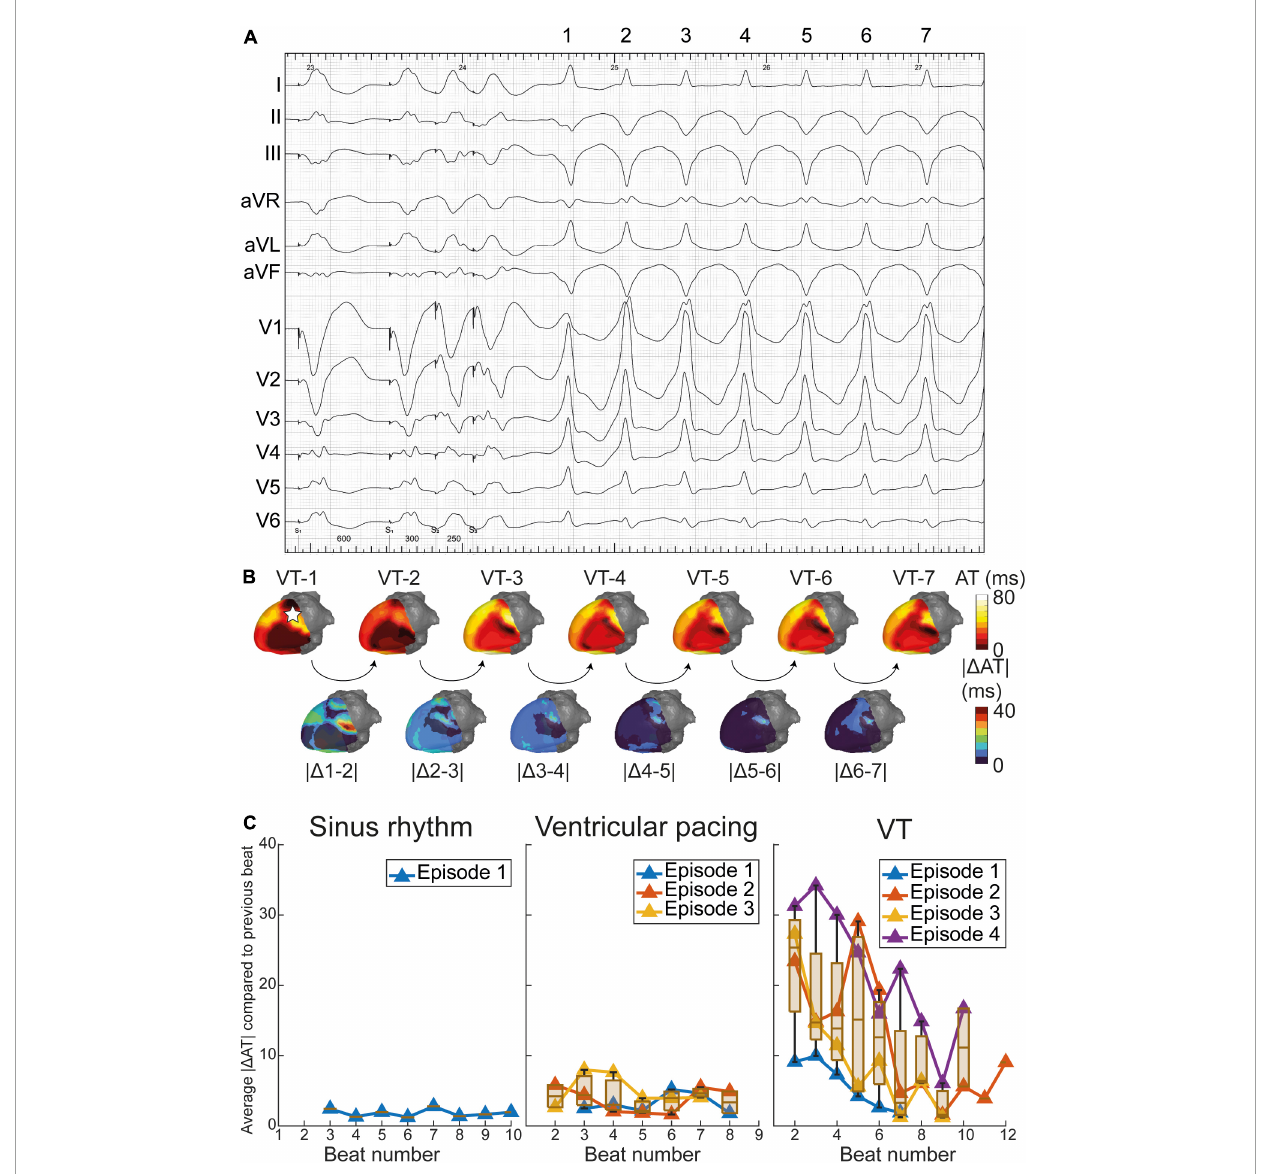
FIGURE5 Dynamics of epicardial activation patterns through electrocardiographic imaging (ECGI). (A) ventricular tachycardia (VT) during procedure in which beats 1 through 7 are depicted. (B) Activation patterns of VT beats 1 through 7, with absolute difference in activation time (AT) of consecutive beats shown below. The pentagram in VT-1 illustrates the origin of the premature ventricular complex (PVC) ( Supplementary Figure 3 ). For reference, dynamics of activation patterns in sinus rhythm (SR) and pacing are also shown. (C) Average absolute difference in activation times of consecutive beats, over the entire epicardium. Dynamics in activation patterns decrease over time for several episodes (inductions) of VT, while SR and ventricular pacing show stable activation